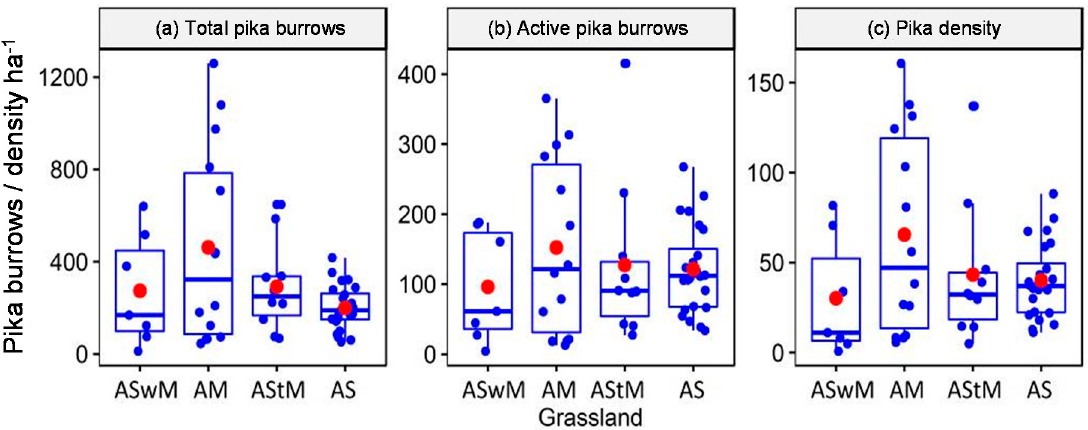
Figure 7. Total pika burrows ( a ), active pika burrows ( b ) and pika density ( c ) of four typical alpine grasslands. Red dots mean the average value. Blue dots are the value of all sampling sites (n = 55). The blue bold solid horizontal lines are the median value. ASwM, AM, AStM and AS indicate alpine swamp meadow, alpine meadow, alpine steppe meadow and alpine steppe, respectively.